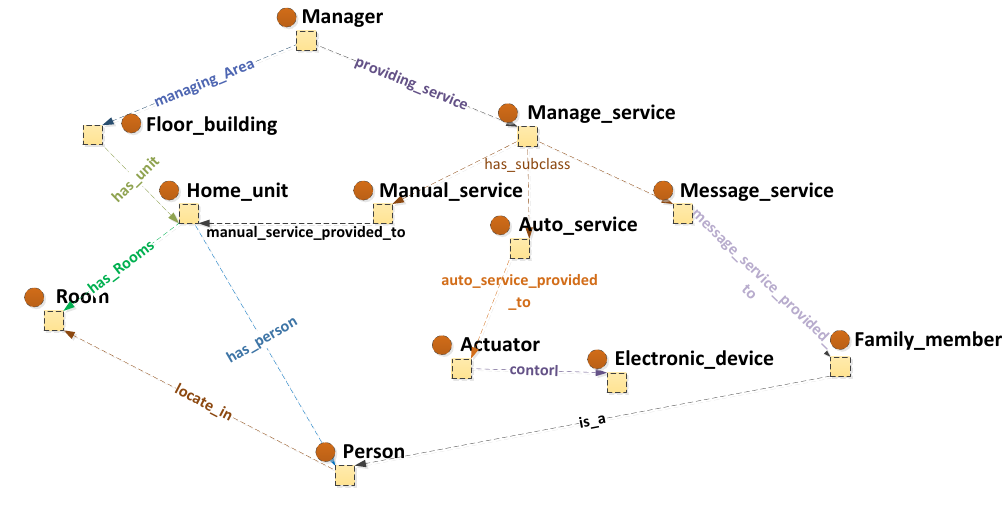
Figure 8. Ontology view focusing on service knowledge.